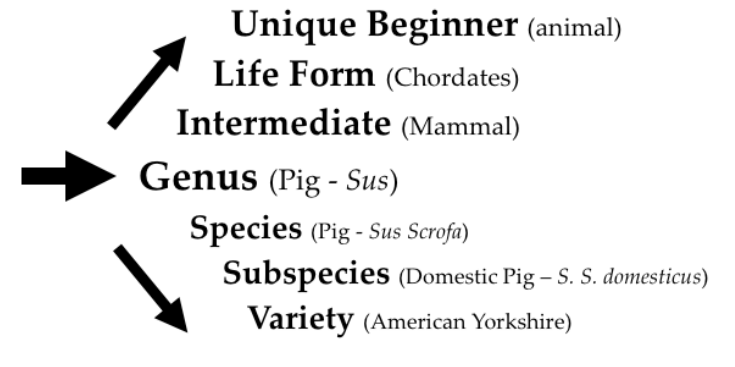
Fig 2: Categorical Development